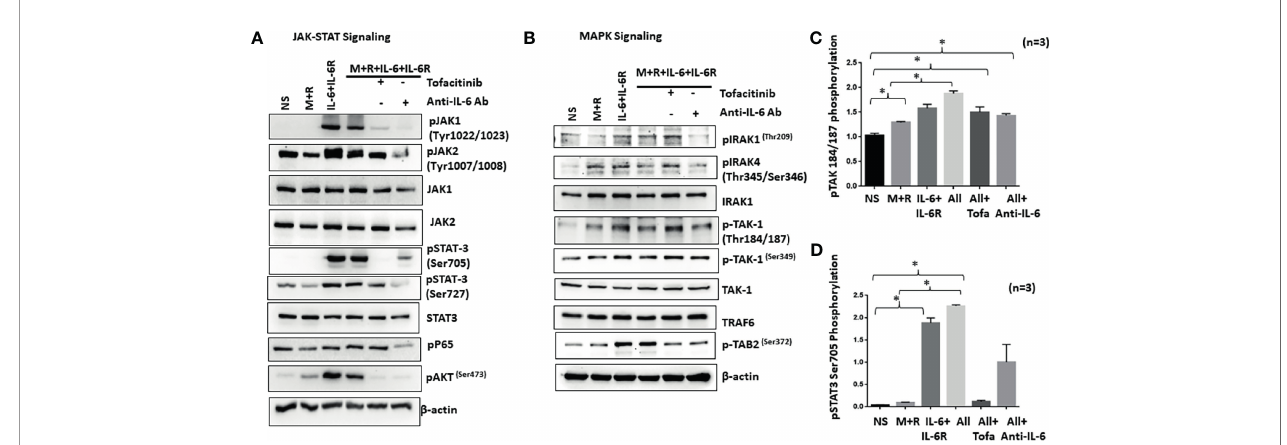
FIGURE 4 | IL-6+IL-6R activates MAPK pathway in addition to canonical JAK-STAT signaling pathway. (A) Stimulation of RASFs with M+R (M-CSF+RANK), IL-6 +IL-6R, and M+R+IL-6+IL-6R (All) activated the canonical JAK-STAT signaling pathway, evidenced by the increased phosphorylation of JAK1, JAK2, STAT3, and AKT, which was abrogated by tofacitinib and anti-IL-6 antibody treatment. (B) M-CSF+RANK, known to engage the MAPK signaling pathway, show cooperativity with IL-6+IL-6R and M+R+IL-6+IL-6R (All)-induced JAK-STAT signaling. Activation of key MAPK proteins by phosphorylation such as TAK1 seems unaffected by tofacitinib or anti-IL-6 antibody pretreatment. (C, D) Quantitative analysis of TAK1 phosphorylation at Thr184/187 and phospho-STAT3 Ser 705 shows M+R+IL-6 +IL-6R (All) samples are unaffected for phosphorylation of TAK1 in presence of inhibitors. *p < 0.05.